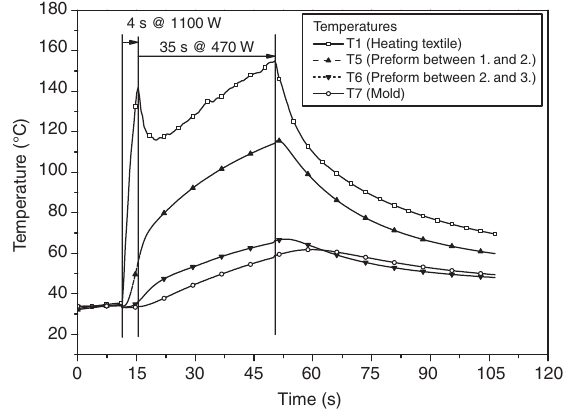
Figure 12 Temperature on heating textile (T1) and in preform (T5/ T6) over time during conductive heating.